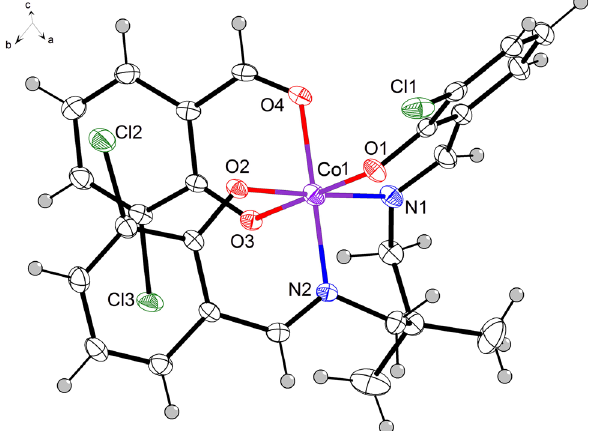
Table  : Data collection and